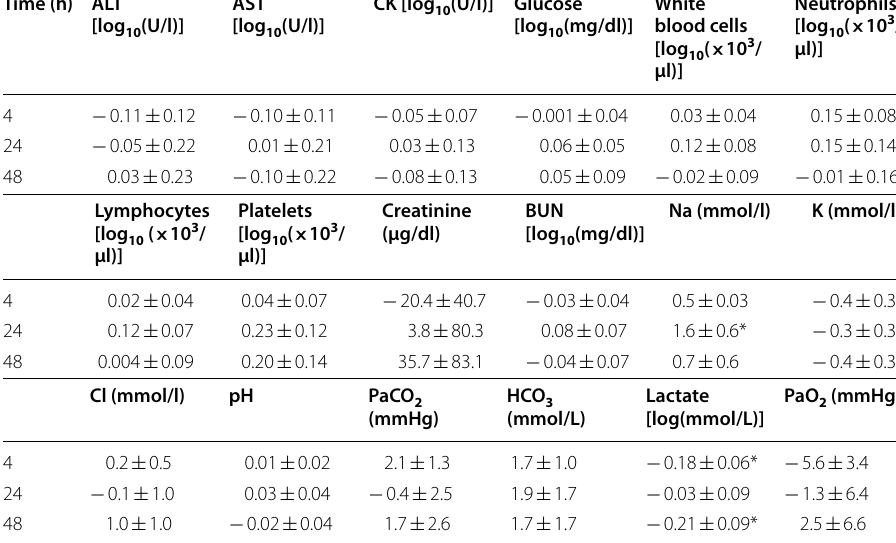
ALT and AST, alanine and aspartate aminotransferases; CK, creatine phosphokinase; BUN, blood urea nitrogen; Na, sodium; K, potassium; Cl, chloride; PaCO 2 , arterial carbon dioxide; HCO 3 , bicarbonate; PaO 2 , arterial oxygen * p ≤